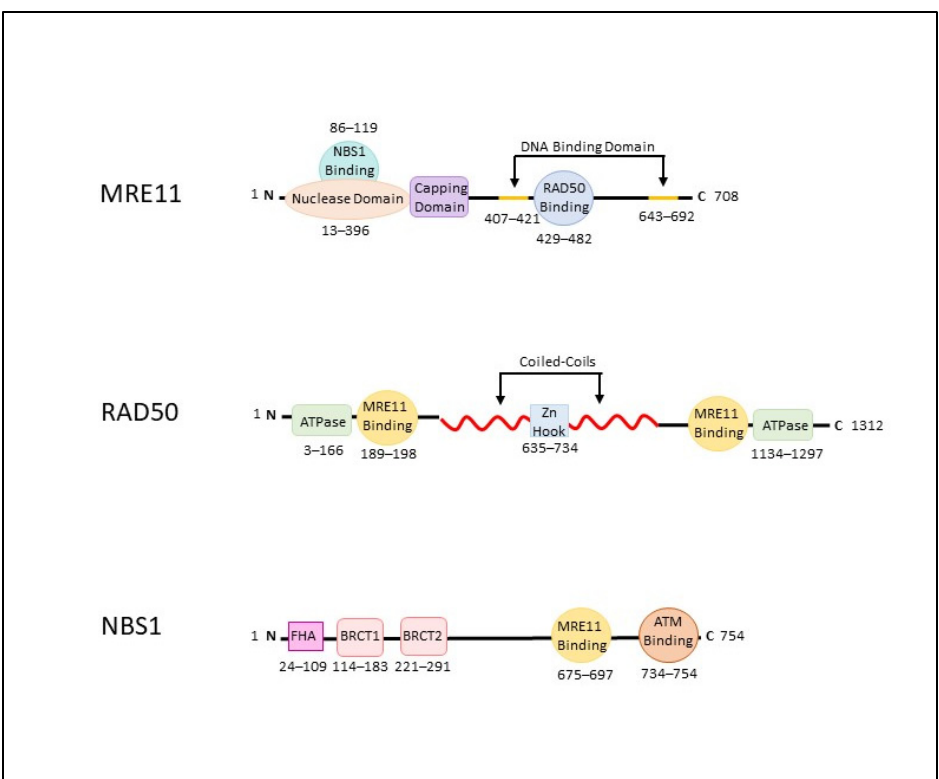
Figure 1. Key domains of the MRN complex. A schematic representation of the three genes that make up the MRE11, RAD50, and NBS1. MRE11 is 708 amino acids (aa) in length. RAD50 is 1312 aa and NBS1 is 754 aa. Domain location within each transcript in indicated (aa) below. (FHA: Fork ‐ head associated domain; BRCT: BRCA1 C ‐ terminal domains).